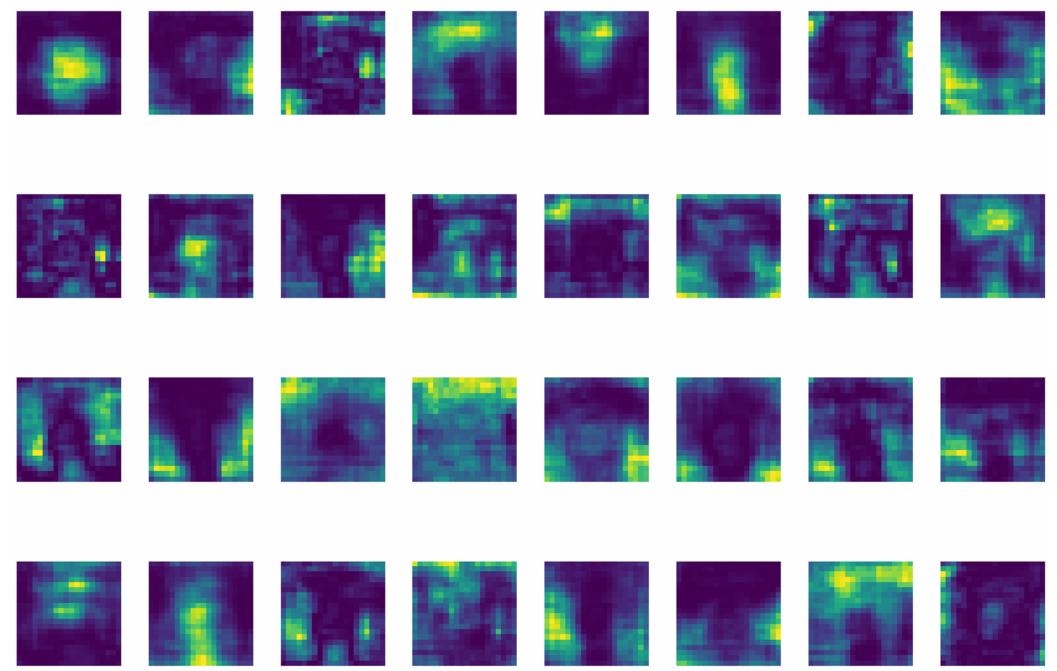
Figure 12. Visualization of the MAFFN module.